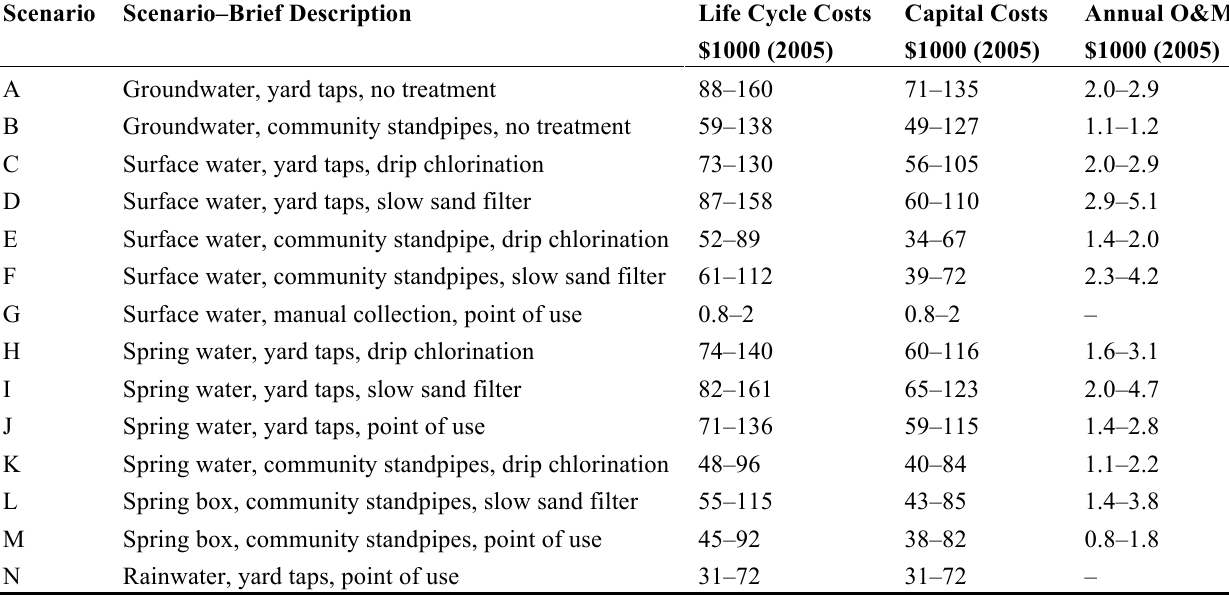
Table 6. Summary of community life cycle costs for rural water